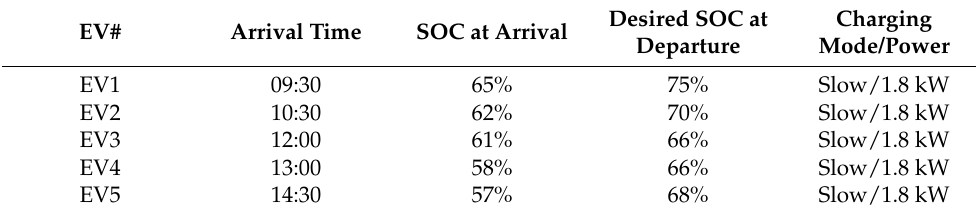
Table 4. Hypotheses for Scenario 2b.